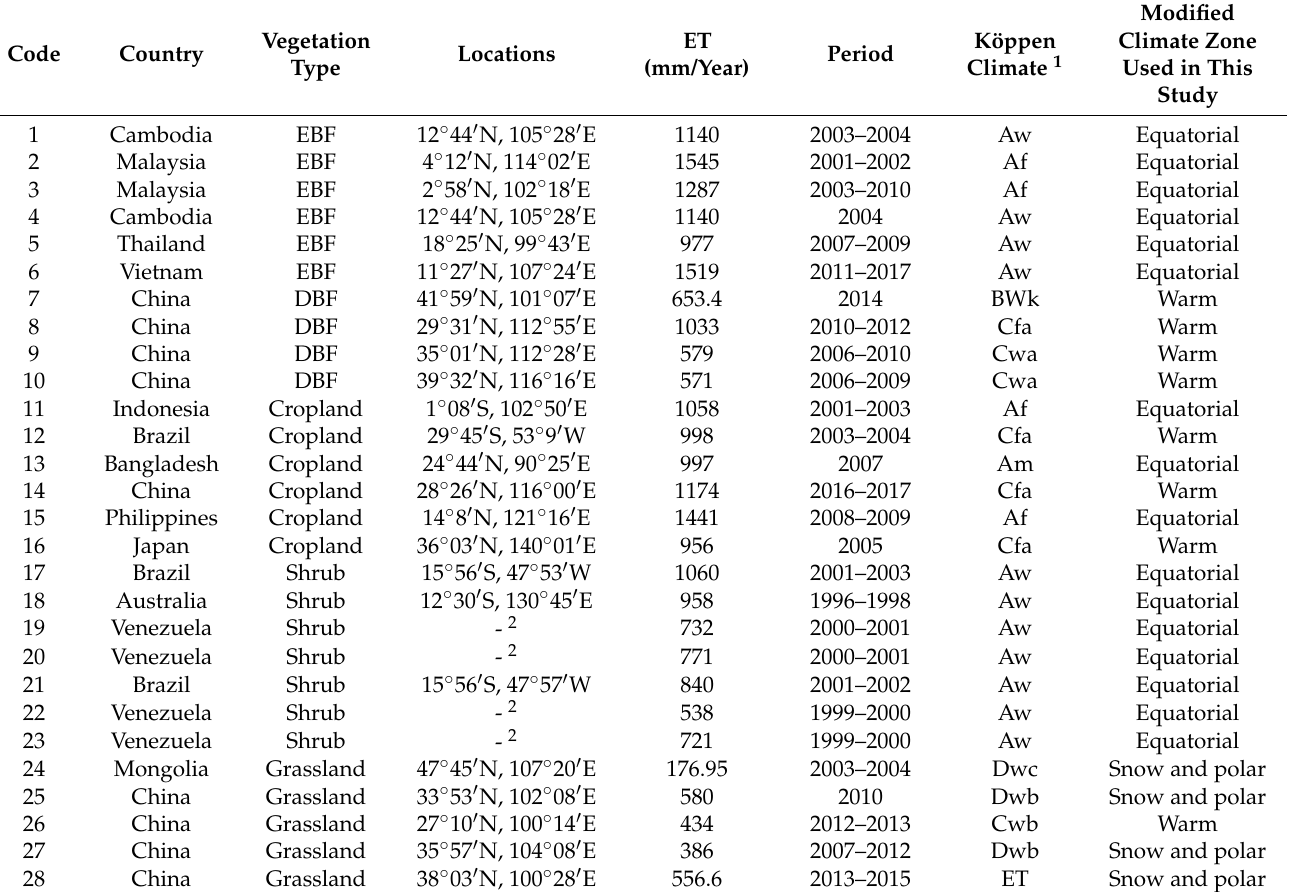
Table A1. Information of 39 EC sites collected from